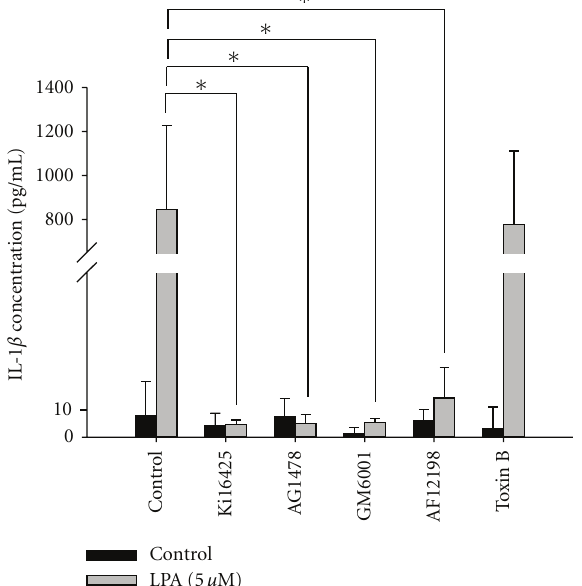
Figure 2: Lysophosphatidic acid- (LPA-) induced interleukin- (IL-) 1 β protein expression is mediated through endothelial growth factor receptor (EGFR) transactivation-, matrix metalloproteinase- (MMP-), LPA1/3-, and IL-1R-dependent mechanisms in human umbilical vein endothelial cells (HUVECs). Starved HUVECs were pretreated with AG1478 (100nM), AF12198 (10 nM), GM6001 (10 μ M), Ki16425 (10 μ M), and toxin B (10nM) for 1 h, followed by LPA (5 μ M) treatment for an additional 24h. Conditioned medium was measured by an ELISA as described in “Methods”. All ELISA data are expressed as the mean ± SD from at least three independent experiments. ∗ P < . 05, ∗∗ P < . 01, and ∗∗∗ P < . 001 indicate a statistically significant di ff erence with the untreated control.